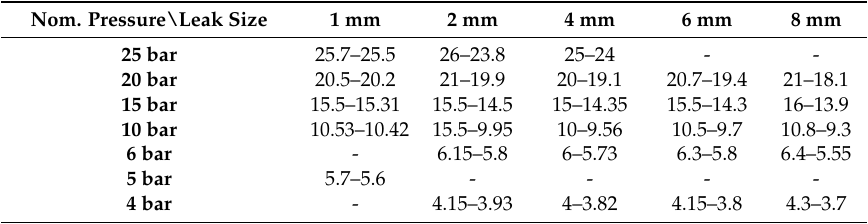
Table 1. Intervals of real pipeline pressures (bars) at which the individual measurements were performed. Listed leak sizes and nominal pressure values will be used to reference the individual measurements throughout the